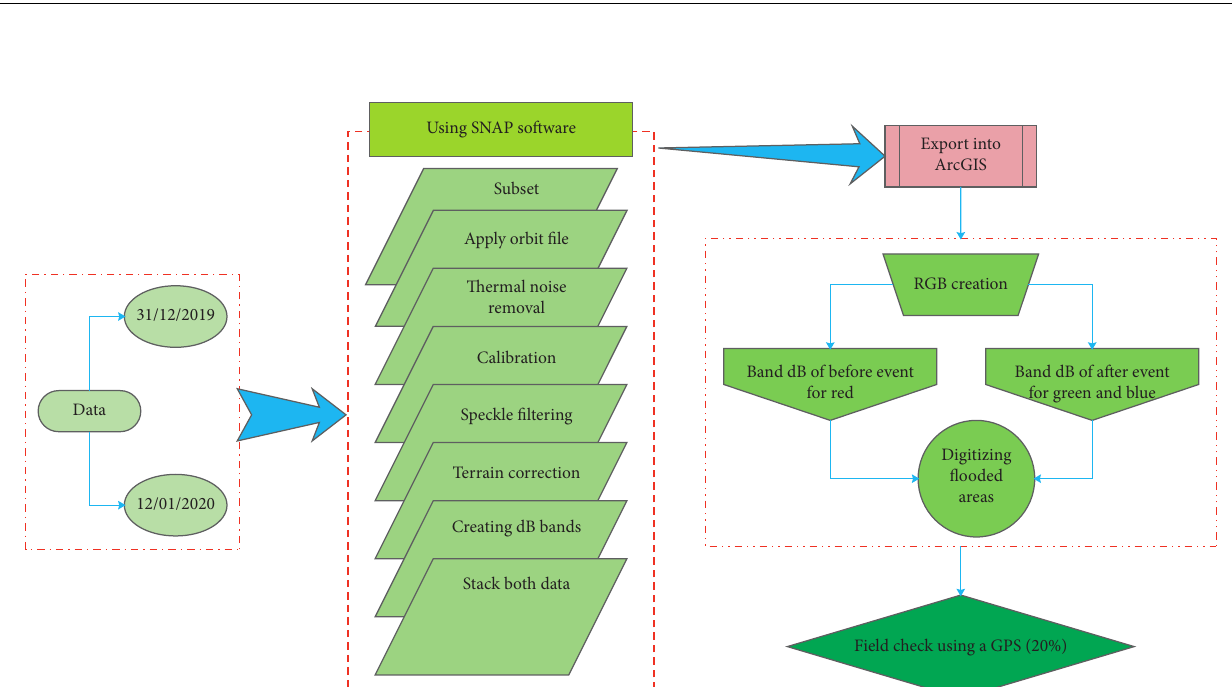
Figure 7: Methodology of flood inventory of the